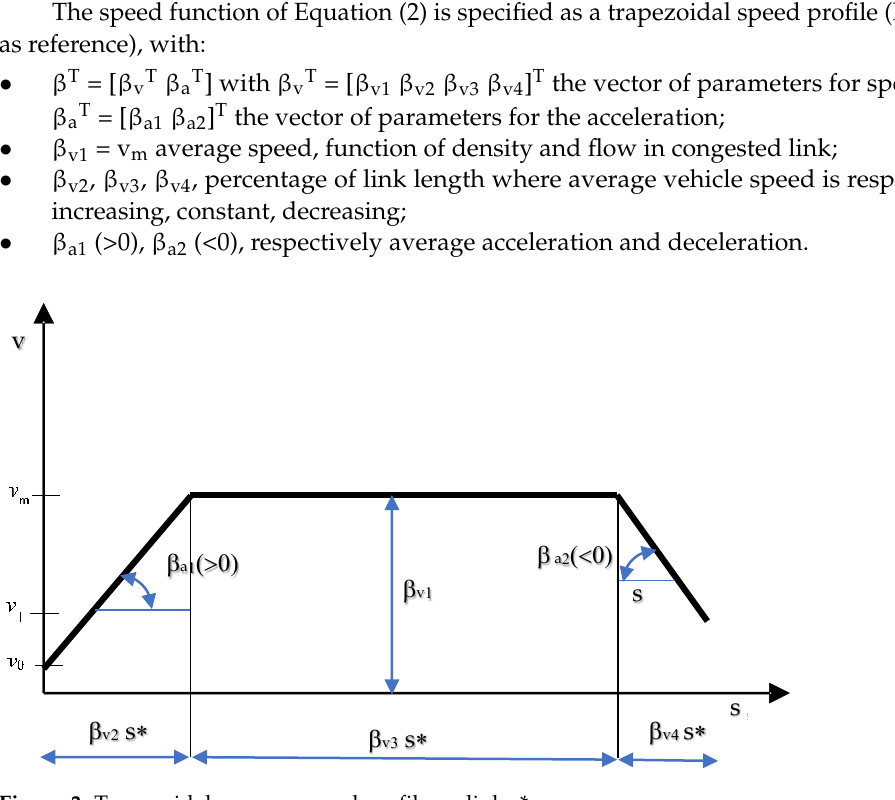
Figure 4.2. Trapezoidal average speed profile on link s*. 383 Figure 3. Trapezoidal average speed profile on link